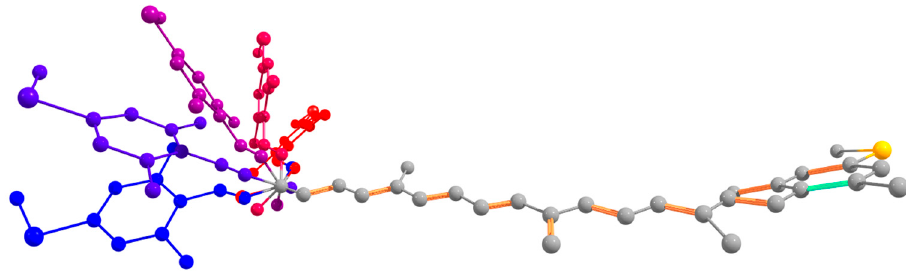
Figure A2. Superposition of structures with θ = 0° (blue), 45°, 90°, 135°, 180° (red). Colour code: S, yellow; C: grey. Hydrogen atoms are omitted for clarity. The structures have not been reoptimized for each studied dihedral angle.